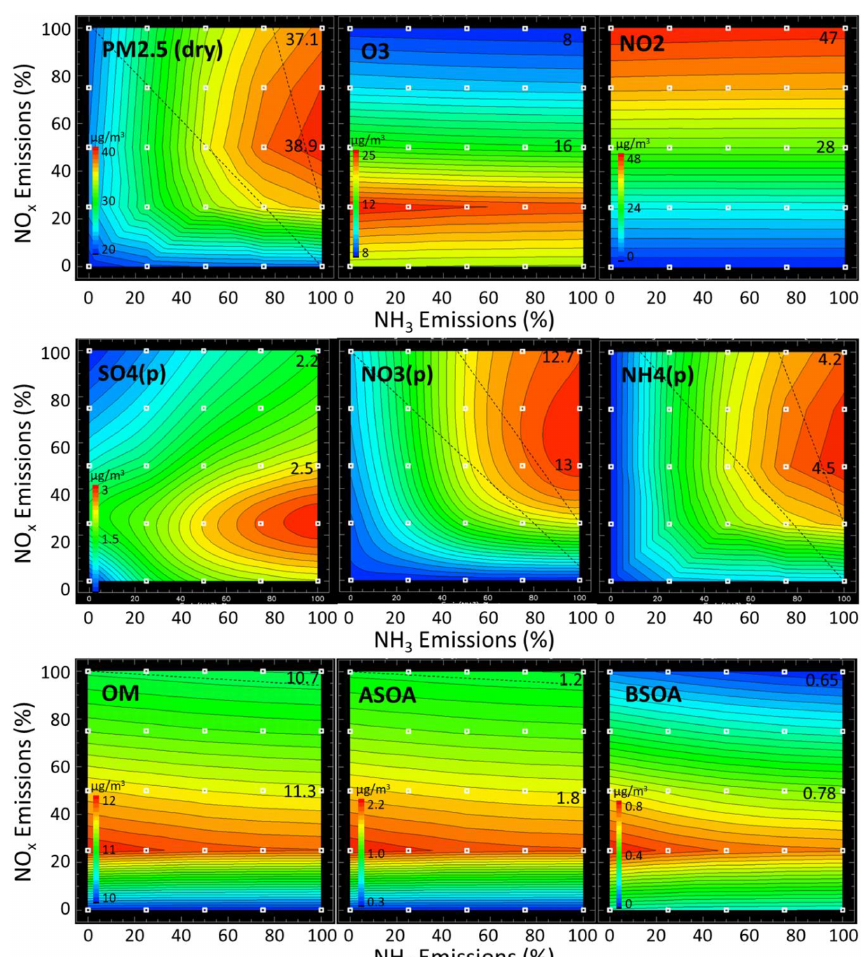
Figure 7. Wintertime isopleths in Bergamo for the species: dry PM 2 . 5 , O 3 , NO 2 , sulfate (SO 4 ), nitrate (NO 3 ), ammonium (NH 4 ), organic matter (OM), and anthropogenic and biogenic secondary aerosols (ASOA and BSOA, respectively). The two numbers on the vertical axis indicate concentration values for the base case and at the 50% NO x emission